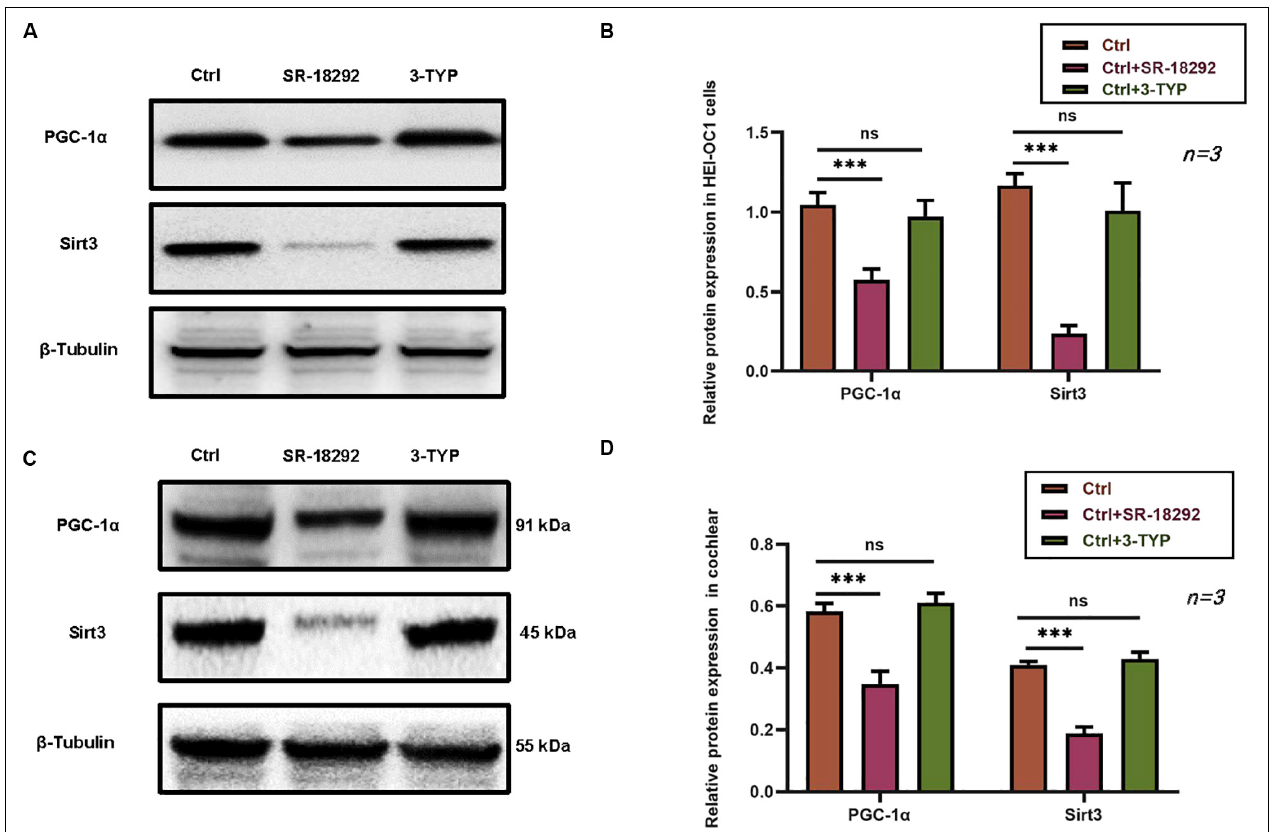
FIGURE 7 | PGC-1 α regulates SIRT3 expression in HEI-OC1 cells and cochlear explants. (A–D) Effect of pretreatment with the PGC-1 α inhibitor SR-18292 and SIRT3 inhibitor 3-TYP on PGC-1 α and SIRT3 protein levels in HEI-OC1 cells (A,B) and cochlear explants (C,D) , as determined by western blotting. The experiment was repeated three times. NS, not significant; ∗∗∗ P < 0.001 (one-way analysis of variance followed by Tukey’s multiple comparisons